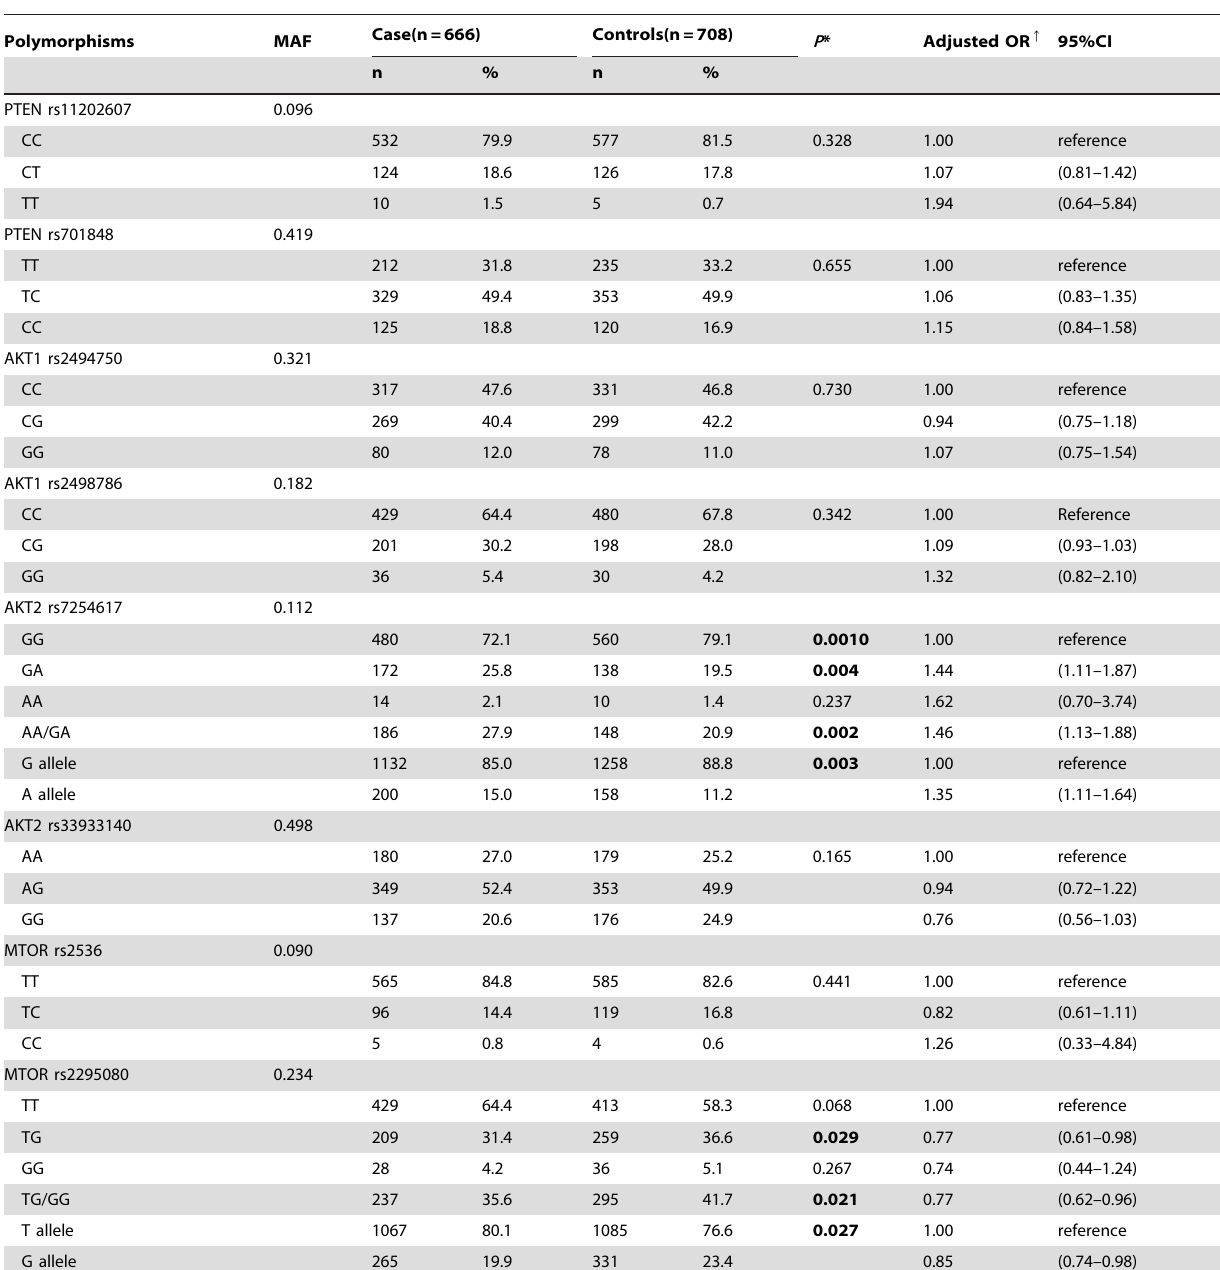
Table 2. SNPs in the PTEN/AKT/mTOR axis associated with the prostate cancer risk.